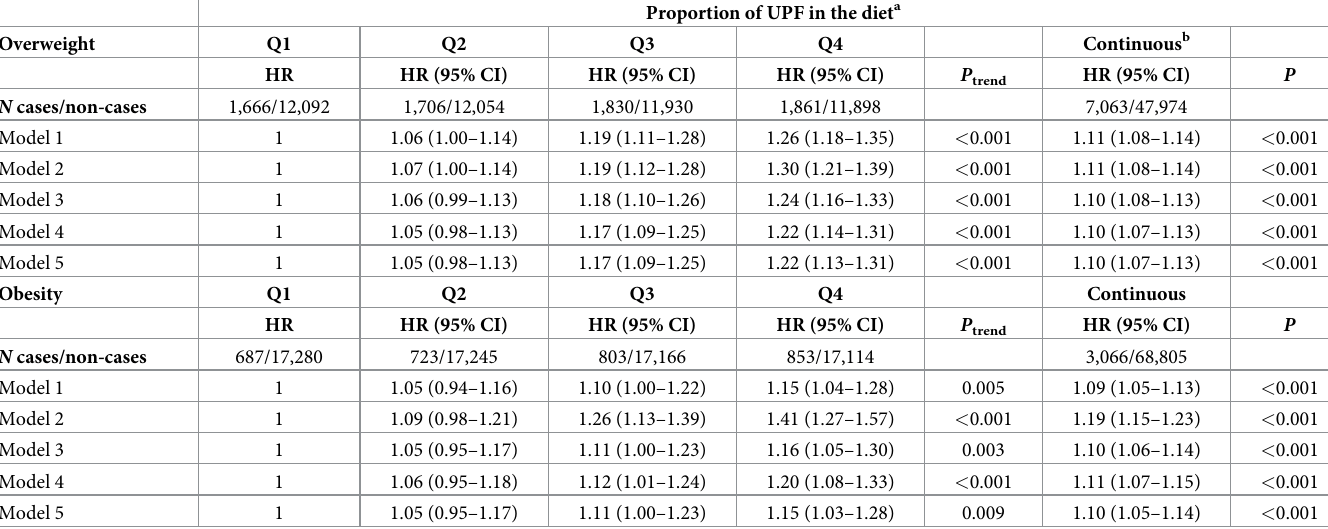
Proportion of UPF in the diet a